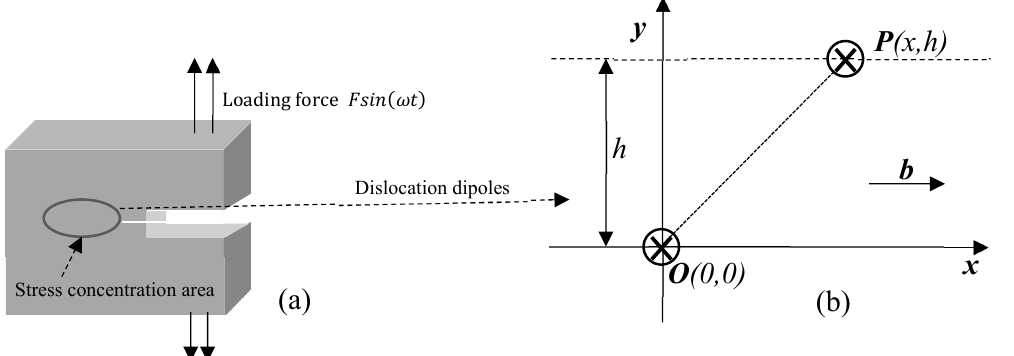
Figure 1. The dislocation dipole model: ( a ) CT specimen ( b ) dislocation dipole.